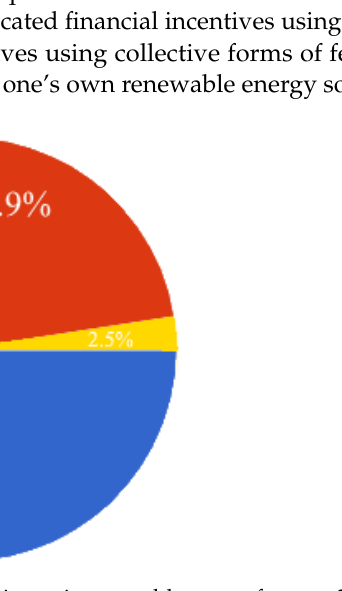
Figure 5. Which forms of incentives would you prefer most?